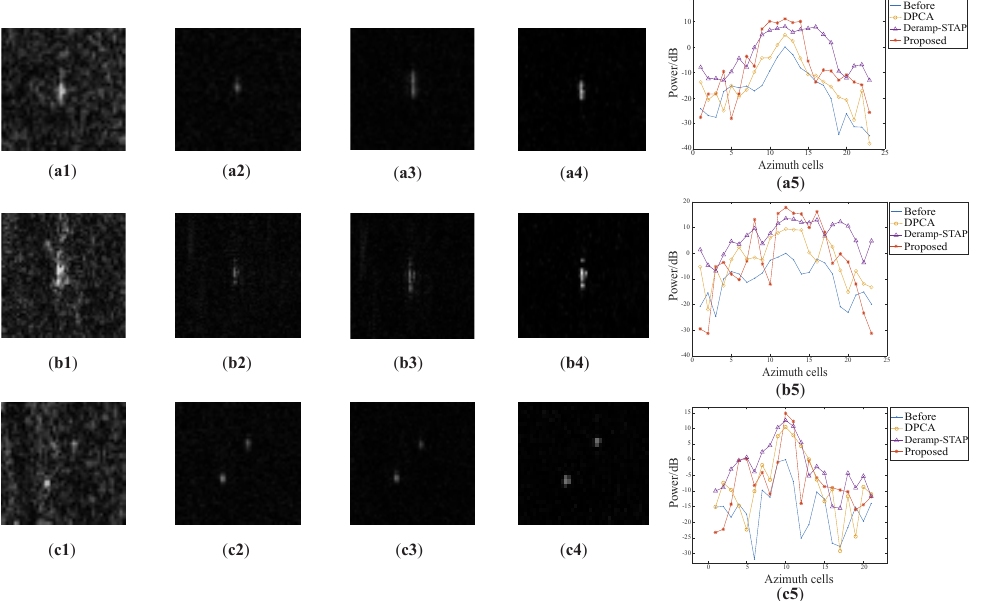
Figure 15. Comparisons of GMTI algorithms in moving target indication, ( a1 ) the moving vehicle I before clutter suppression, ( a2 – a4 ) clutter suppression result by the DPCA, the Deramp-STAP and the proposed multilayer channel-cancellation, ( a5 ) the slice of amplitude enhancement of the vehicle I by the three algorithms, ( b1 ) the moving vehicle II before clutter suppression, ( b2 – b4 ) clutter suppression result by the DPCA, the Deramp-STAP, and the multilayer channel-cancellation, ( b5 ) the slice of amplitude enhancement of the vehicle I, ( c1 ) a general vehicle on the Jingliang Road, ( c2 – c4 ) clutter suppression result by the DPCA, the Deramp-STAP, and the multilayer channel-cancellation, ( c5 ) the slice of amplitude enhancement of the general vehicle.